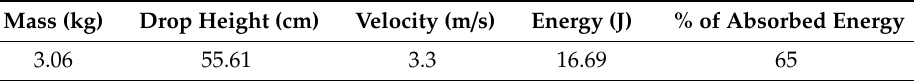
Table 1. Impact testing conducted on a 2-mm quasi-isotropic composite coupon.